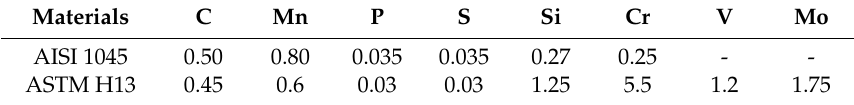
Table 1. Chemical composition of AISI 1045 carbon and ASTM H13 tool steels in (wt.%).